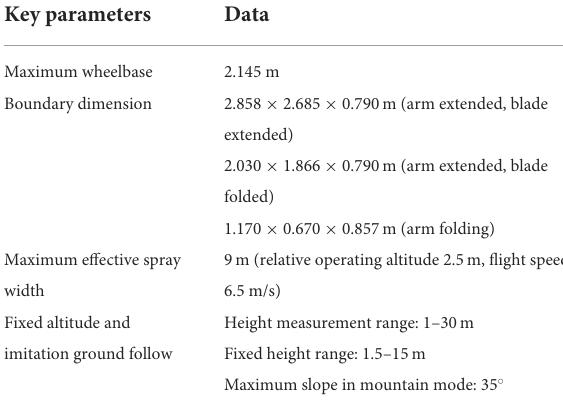
TABLE 1 T30 model agricultural plant protection UAV data. Key